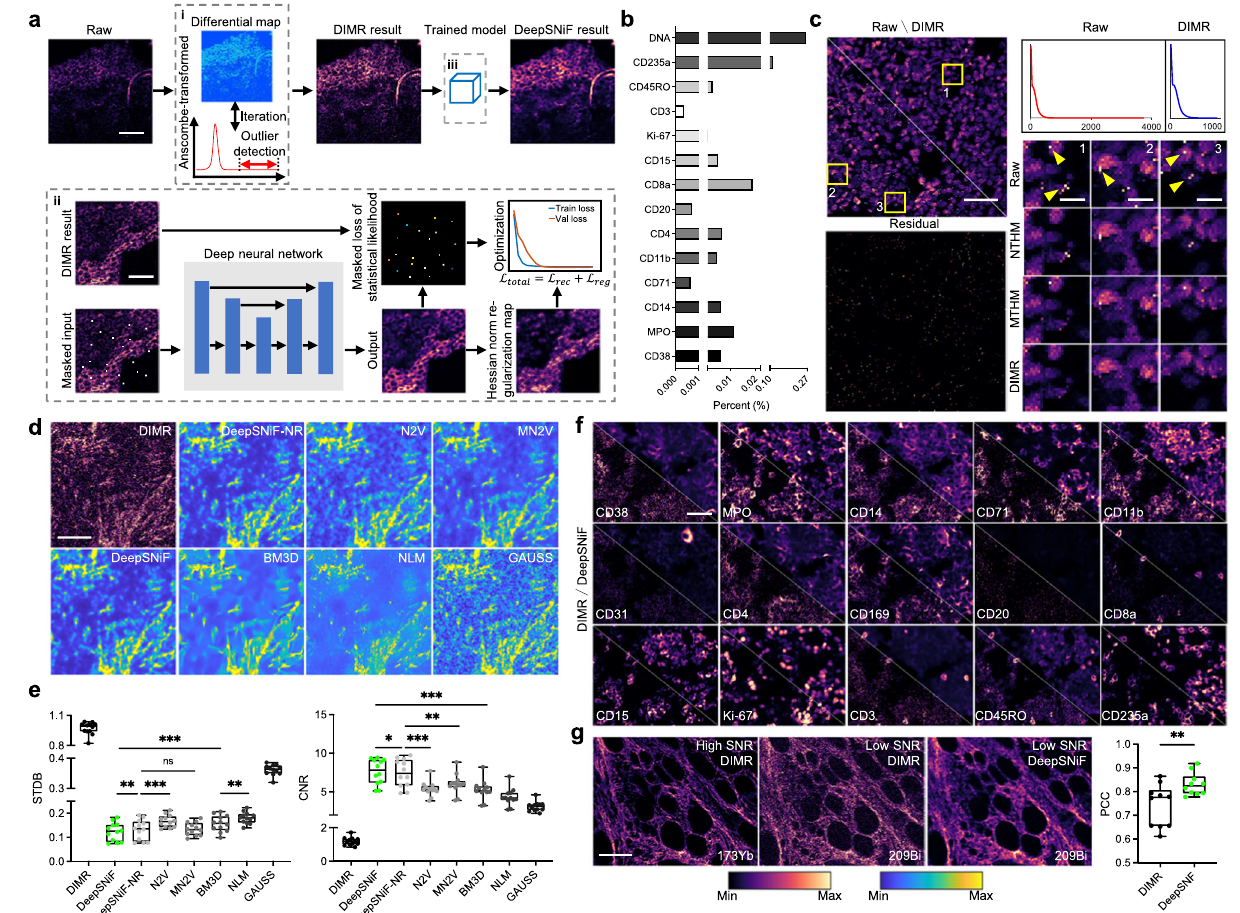
Fig. 1 | General principle and validation of IMC-Denoise on the human bone marrow IMC dataset. a Schematic of IMC-Denoise: (i) the DIMR algorithm: after the Anscombetransformation, the difference maps calculated from the raw image are operated to form a histogram. The outliers are detected based on this histo- gram and removed by a3×3median fi lter,iteratively.(ii)The training phase of the self-supervised DeepSNiF algorithm: In the hot pixel corrected images, several pixels are randomly selected and masked. The hot pixel corrected images before and after the masking are set as the outputs and inputs of a deep neural network, respectively. Statistics-derived I-divergence on the masked pixels combined with the Hessian norm regularization on all the pixels is set as the loss function to guarantee the optimal denoising performance. (iii) The prediction phase of the DeepSNiF algorithm: the hot pixel corrected IMC images are fed into the trained network to account for the shot noise. b The fractions of detected hot pixels by DIMR inselected channels. c DIMRremoves hotpixelsin DNA intercalator channel effectively. Left: Comparison of the raw and DIMR-processed images; and the